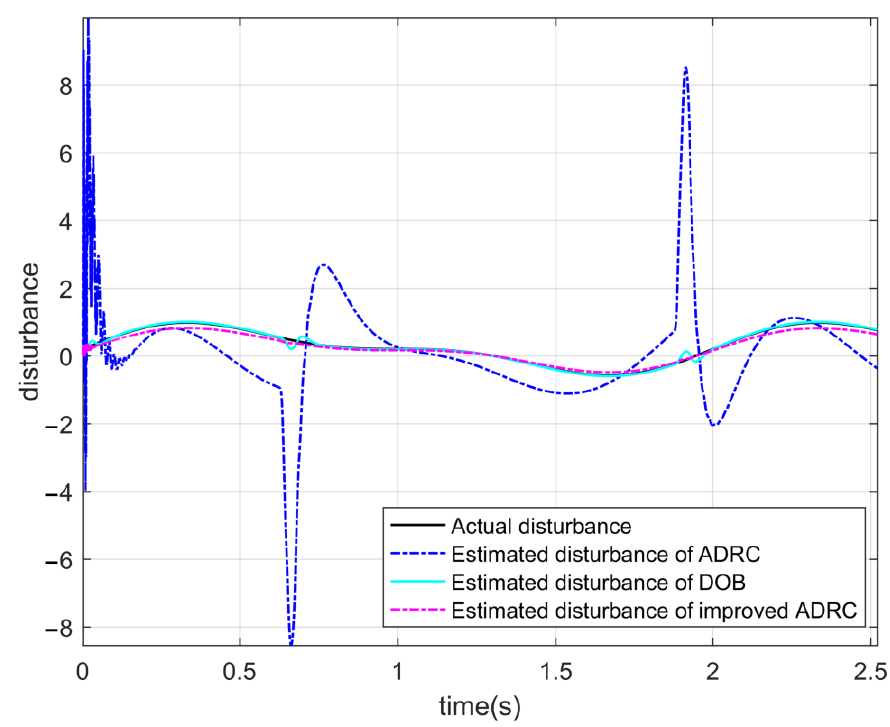
Figure 15. The observed disturbance curves of the three controllers. Table 5. The tracking performance of the three controllers after adding disturbance.